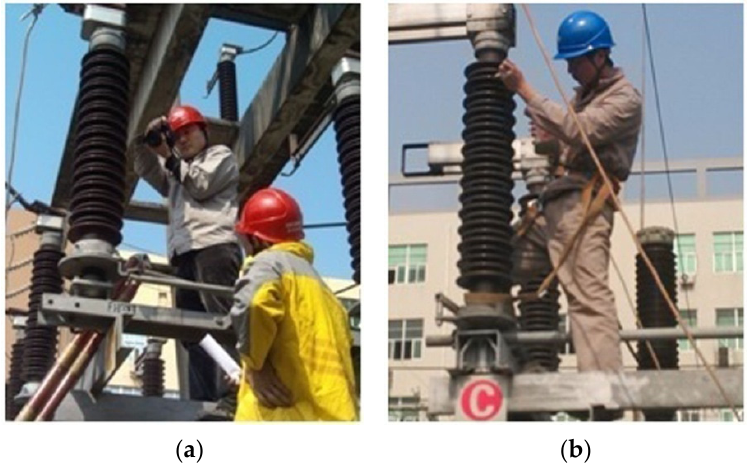
Table 1. Standard for theinsulator contamination grades.